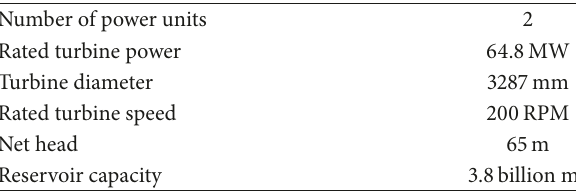
Table 1: Corumb´a IV HPP main technical